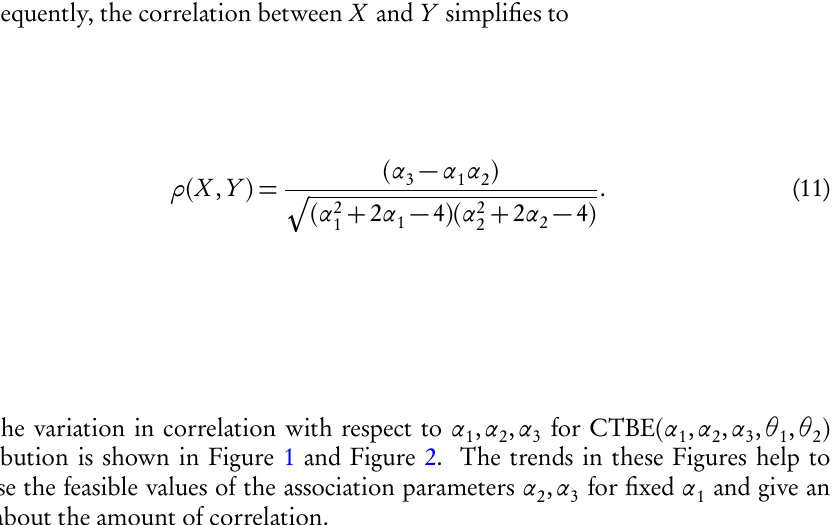
Figure 1 – Correlation w.r.t. α